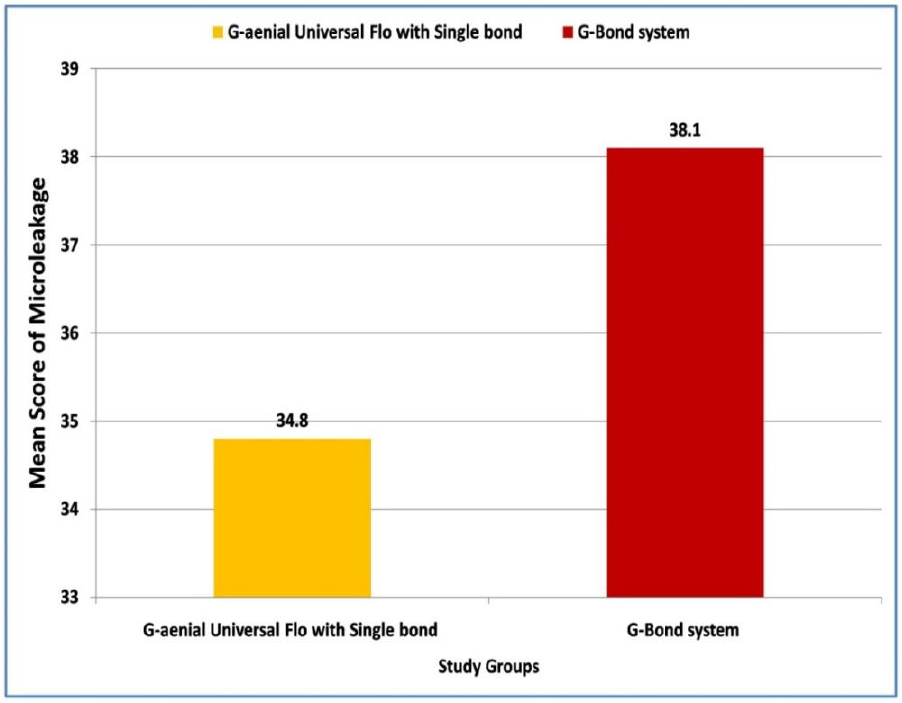
Figure 2. Comparison of mean values of microleakage in class V cavities with Single Bond and G-Bond system, using G-aenial Universal Flo.